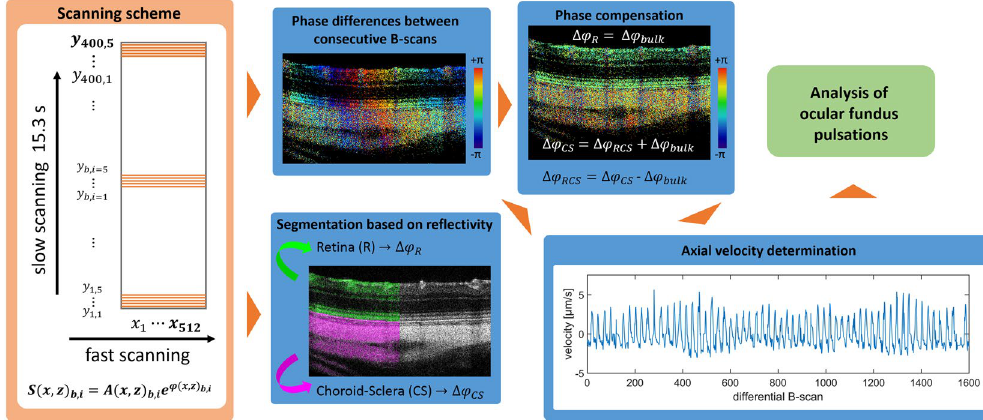
Figure 1. Overview of the ocular fundus pulsation measurement. A repeated raster scanning pattern was used to perform phase-differencing between consecutive B-scans. After segmenting the retinal and chorioscleral region, bulk phase shifts (estimated in the retina) were subtracted from each B-scan and the remaining average phase differences between the retina and chorioscleral complex were calculated. The axial velocities of these deformations were subsequently used for a quantitative spectral